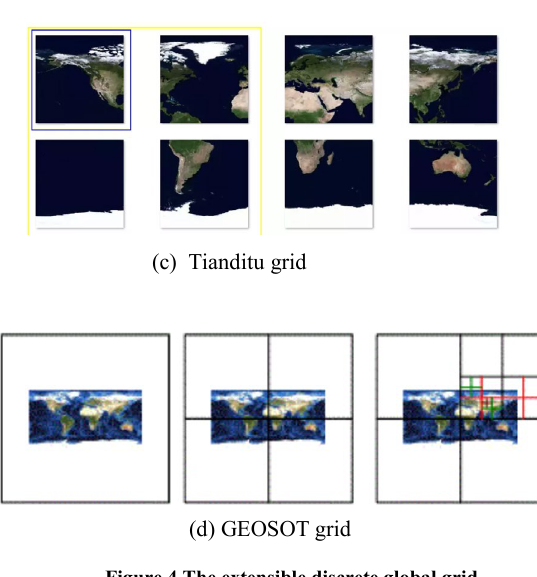
Figure 4.The extensible discrete global